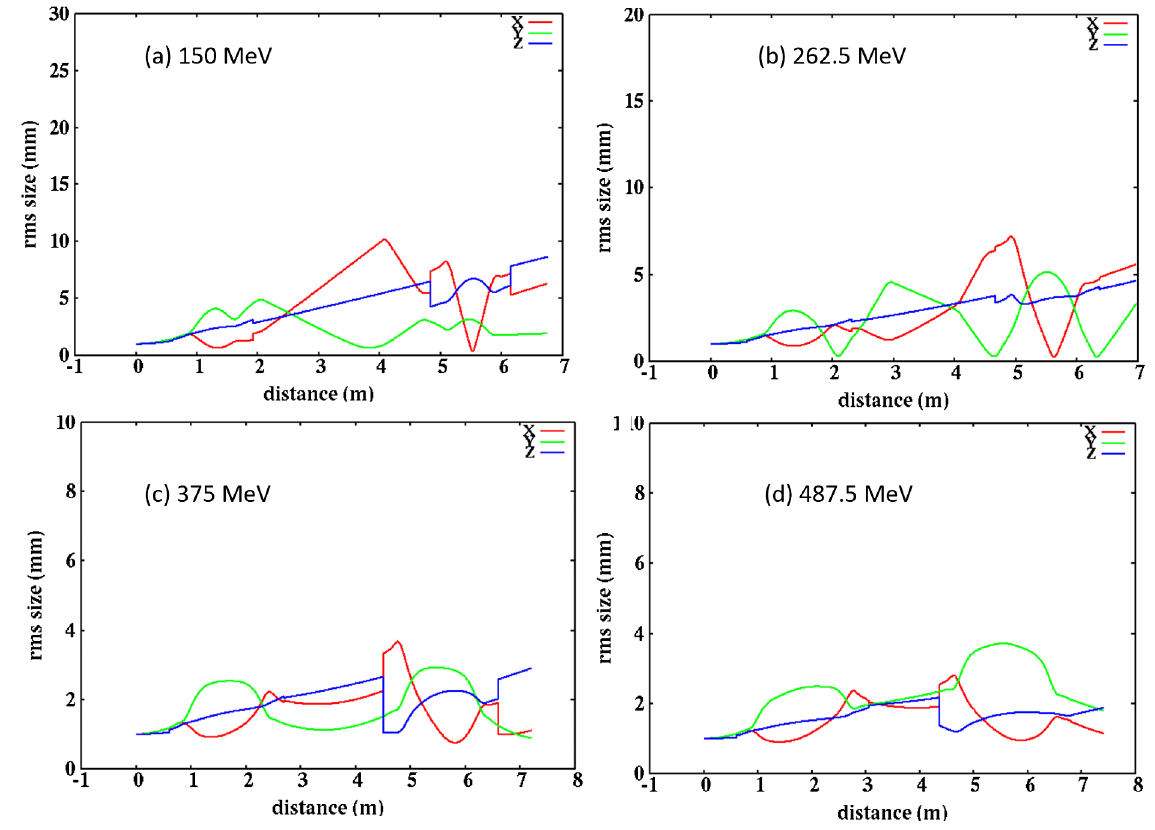
FIG. 9. Proton beam transverse and longitudinal RMS size evolution through the phase shifter with 150 MeV (top left), 262.5 MeV (top right), 375 MeV (bottom left), 487.5 MeV (bottom right) kinetic energy, initial Gaussian distribution, and 40 mA current.